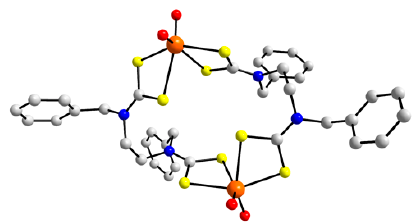
Figure 2. The di-nuclear molecule of [Mo(=O) 2 (L 1 )] 2 in the crystal of 1 . Colour code and protocols for this and subsequent diagrams: central metal atom, orange; sulphur, yellow; red, oxygen; blue, nitrogen; grey, carbon. Hydrogen atoms have been omitted for clarity.